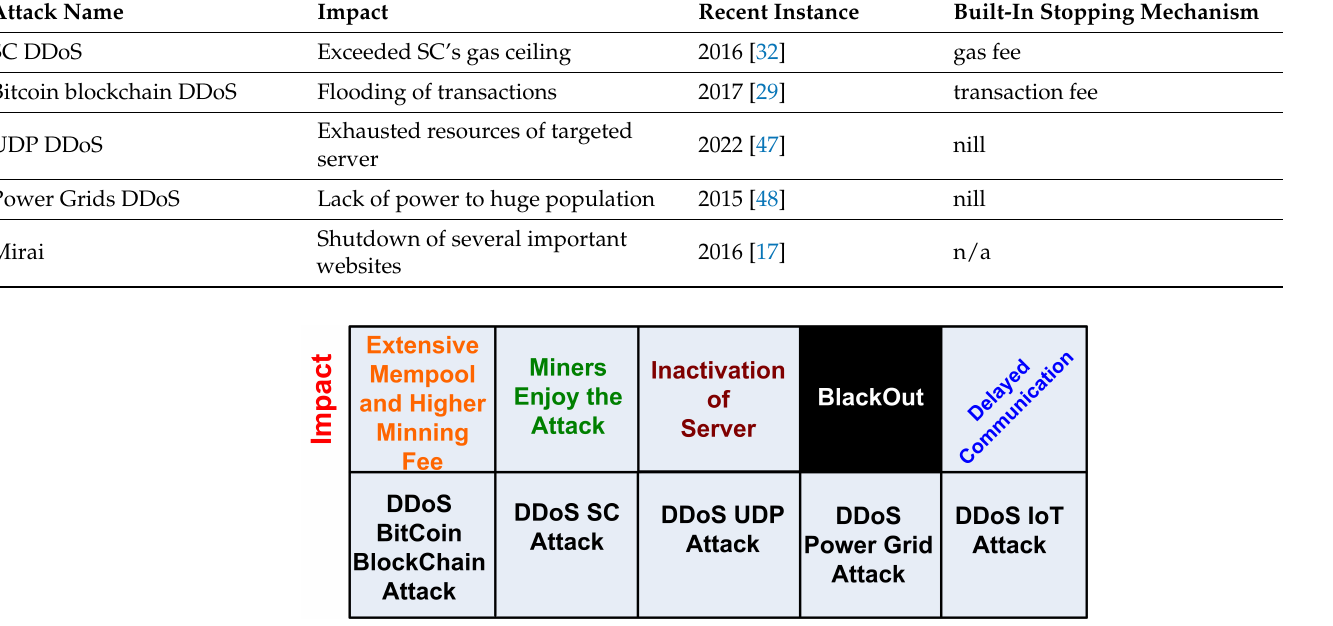
Table 3. Comparison of DDoS Attacks on IoT Subsystems and the Mirai Attack.